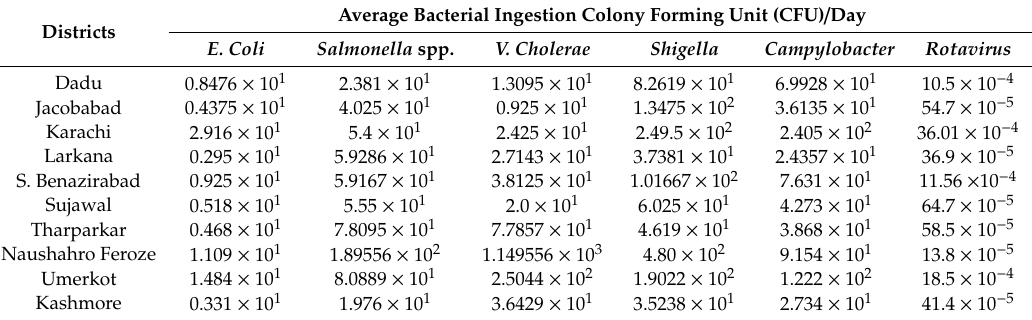
Table 4. Average bacterial ingestion by